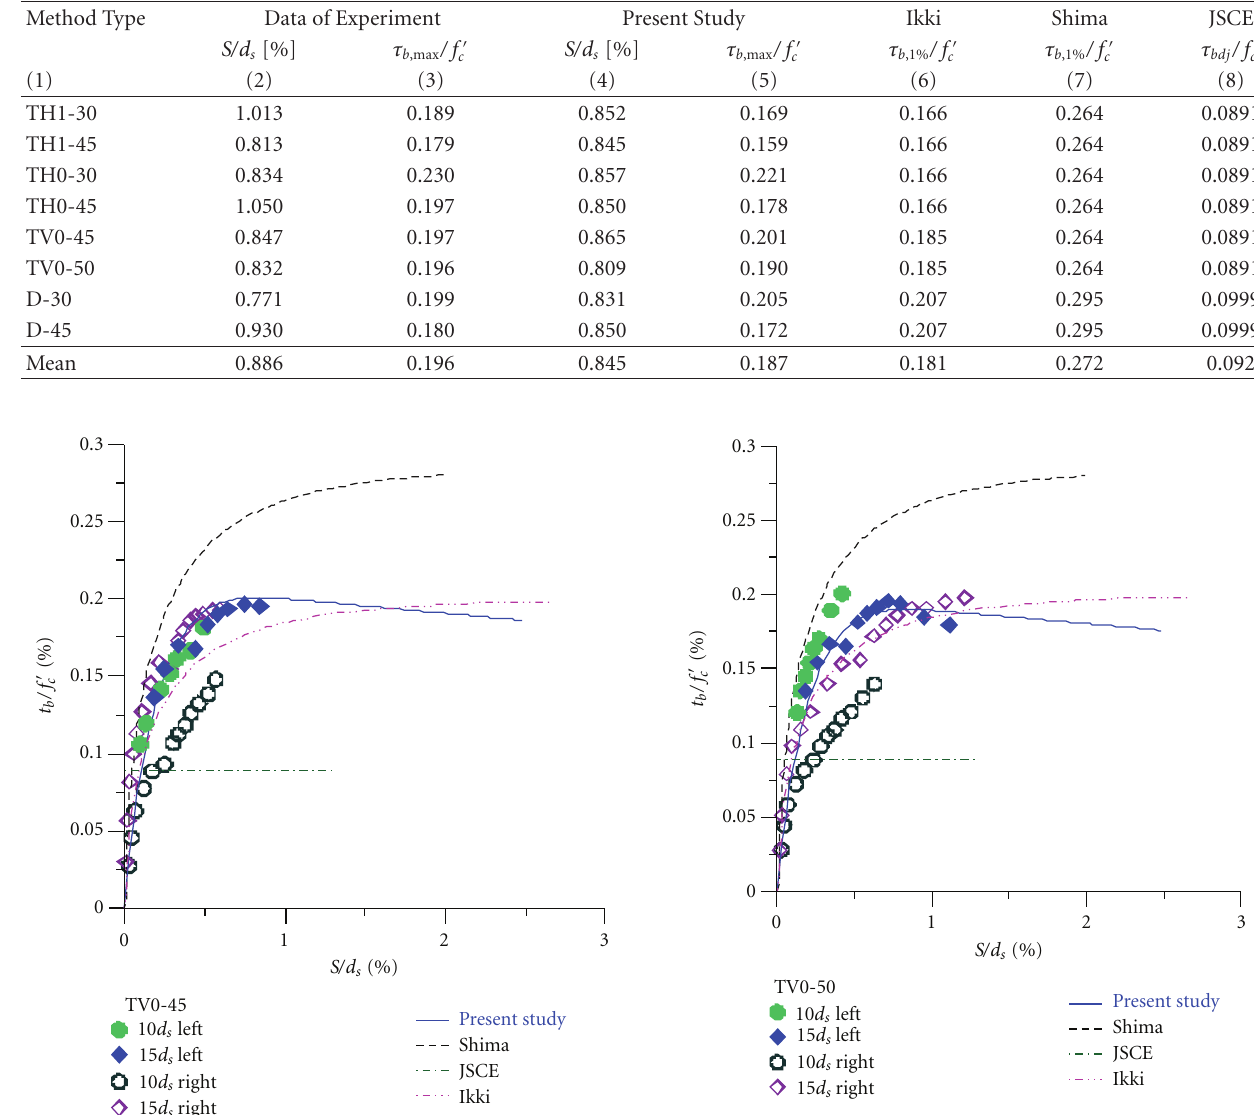
Table 2: Comparison results for the maximum bond stress and the associated slip.